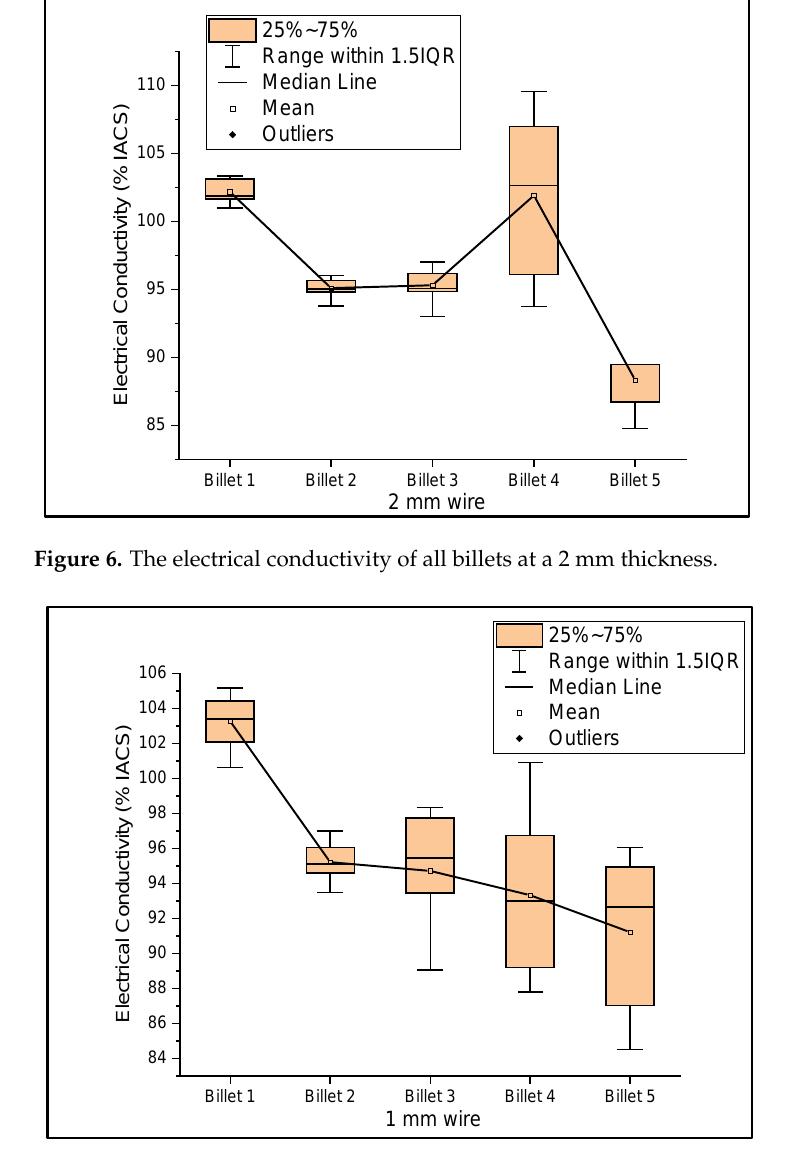
Figure 7. The electrical conductivity of all billets at a 1 mm thickness.